Question: What does this figure show? Answer in one sentence.
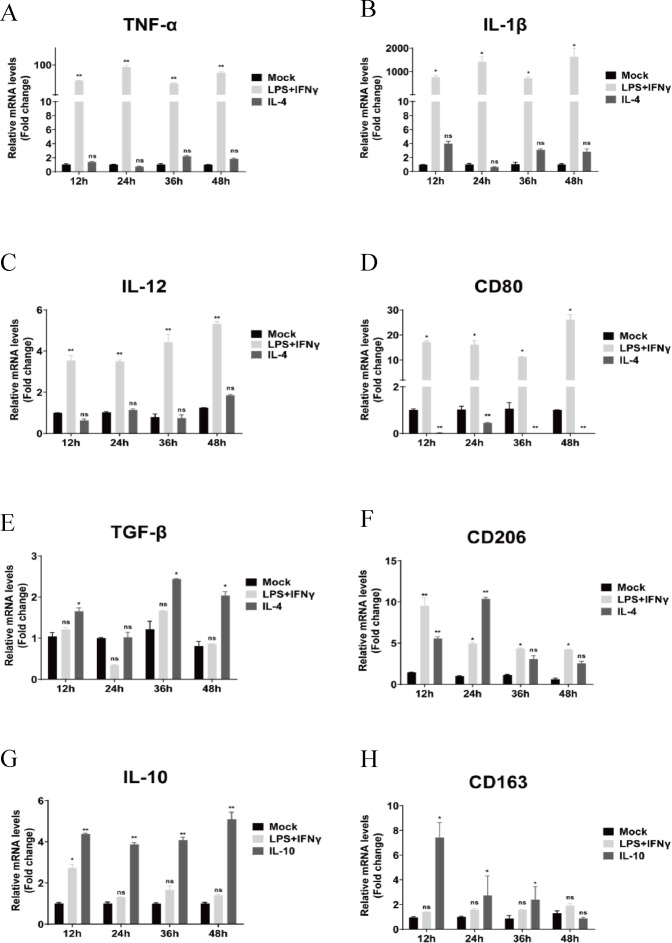
Answer: qRT-PCR analysis to determine optimal stimulation procedure for macrophage polarization. mRNA levels of genes of M1- and M2-type macrophages were monitored using qRT-PCR analysis following treatment with various concentrations of LPS/IFN-γ, IL-4, or IL-10, respectively. ( A–D ) Figure panels show the expression of M1-type macrophage polarization markers, such as TNF-α, IL-1β, IL-12, and CD80, after 12, 24, 36, and 48 h of incubation. ( E–H ) Figure panels show the distinct expression profiles of M2-like markers, specifically the IL-4-induced upregulation of TGF-β ( E ) and CD206 ( F ), and the IL-10-induced upregulation of IL-10 ( G ) and CD163 ( H ), after 12, 24, 36, and 48 h of incubation. Data represent the mean ± standard error of the mean (SEM) of at least three independent experiments.